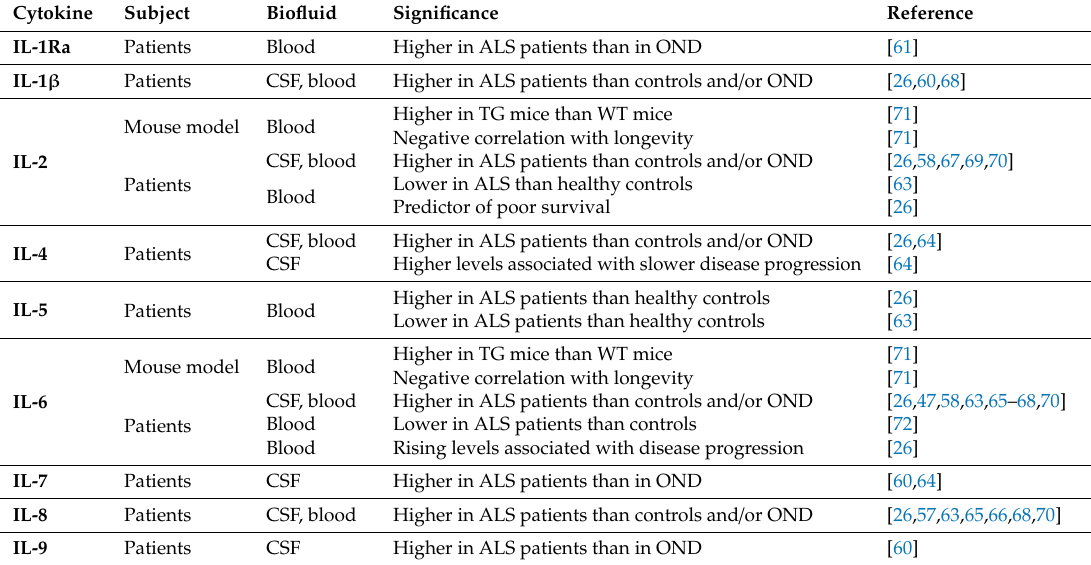
Table 1. Interleukins (IL) found dysregulated and proposed as biomarkers in biofluids from ALS animal models and